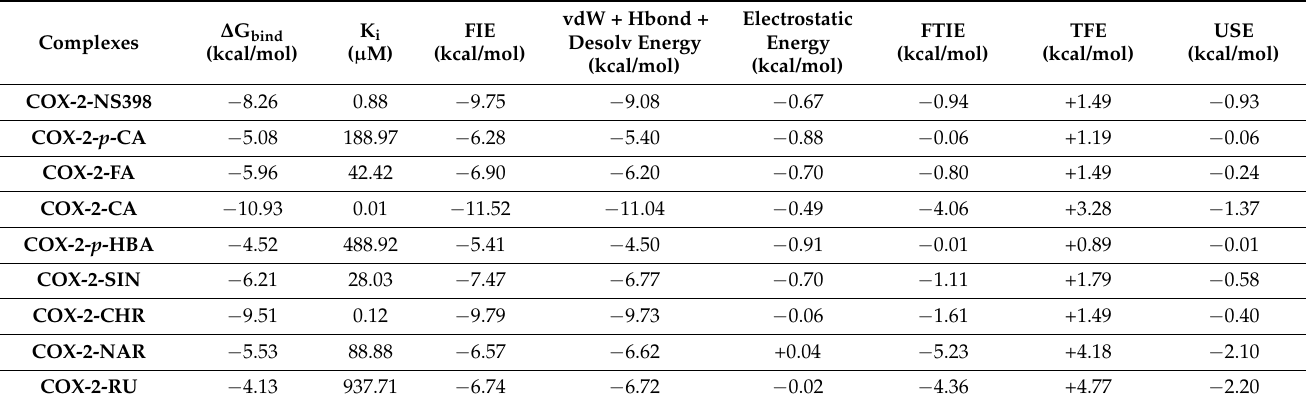
Table 6. Important thermodynamical parameters from docking simulations between NS398, selected compounds p -coumaric acid ( p -CA), ferulic acid (FA), chlorogenic acid (CA), p -hydroxybenzoic acid ( p -HBA), sinapic acid (SIN), chrysoeriol (CHR), naringin (NAR), and rutin (RU) with